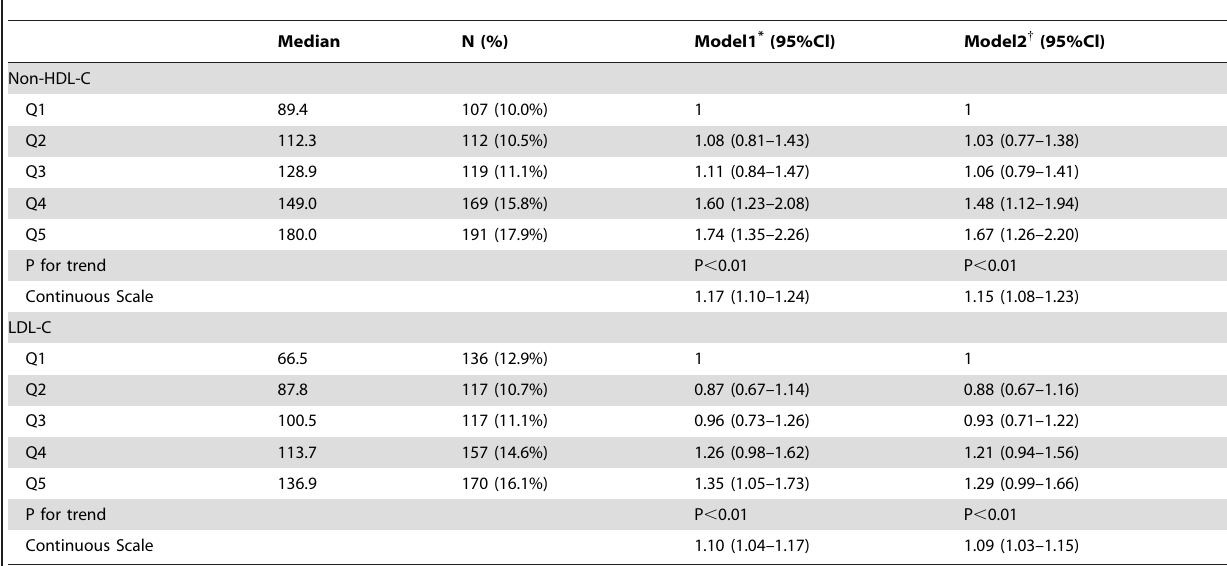
Table 2. Odd ratios (OR) for ICAS according to baseline blood lipid levels